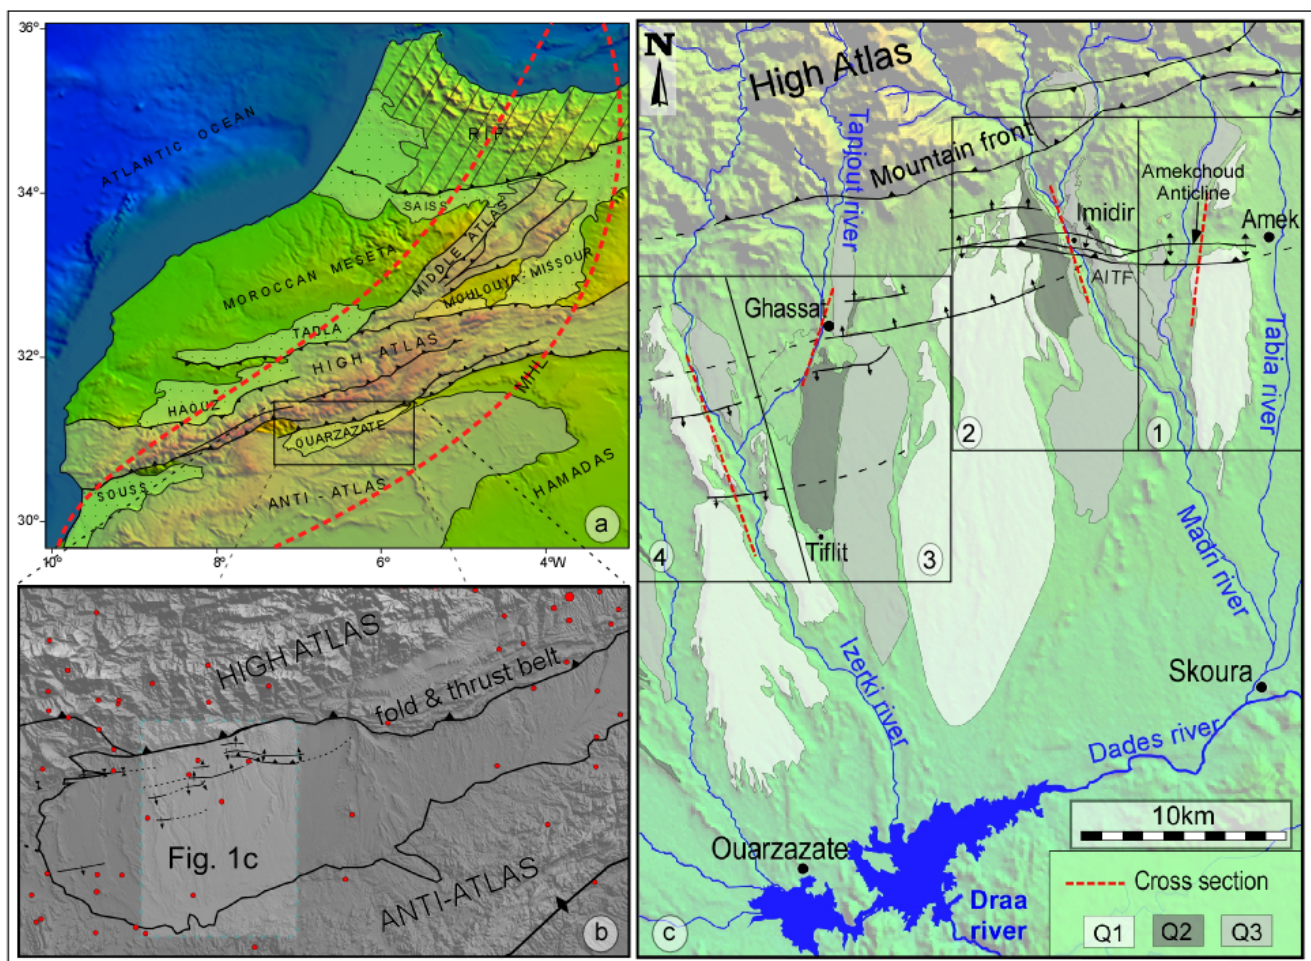
Figure 1. (a) Digital topography and tectonic sketch map of Morocco [after Teixell et al. 2009], showing the main morphotectonic units and the Moroccan Hot Line (MHL). Light dotted areas indicate Cenozoic basins. (b) Sketch map of the Ouarzazate Basin, indicating seismic events Mv >3 since 1964 (extracted from International Seismological Centre database). Background topography: Shuttle Radar Topographic Mission (SRTM90) composed image. The solid line encloses the extent of Tertiary and Quaternary deposits in the basin. (c) Map of the central part of the Ouarzazate Basin indicating the main Quaternary deposits (Q1 to Q3; see text for explanation) and structures. Boxes and numbers indicate the divisions of the study zone into the four areas (see text). Red dashed lines indicate the location of the geological cross-sections in Figure 3. Amek: locality of Amekchoud; AITF: Amekchoud-Imidir thrust